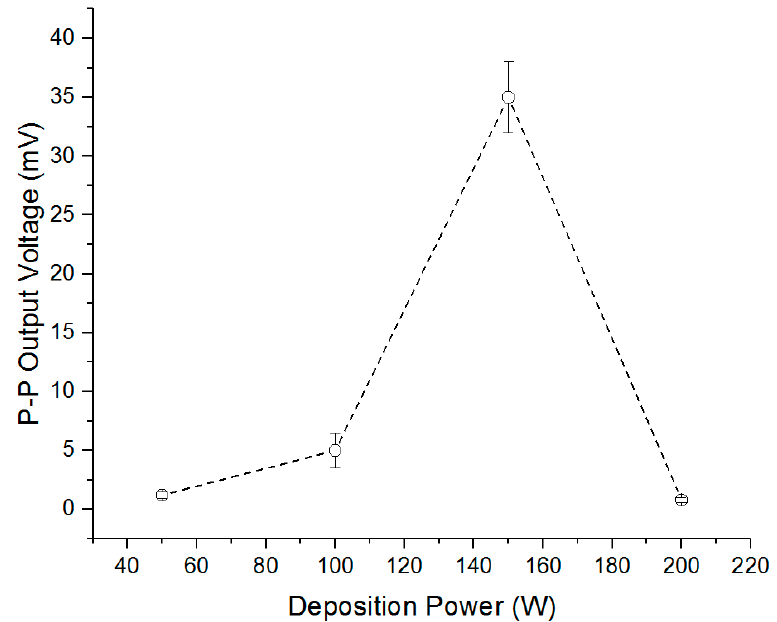
Figure 10 . Peak to peak (P–P) output voltage variations of the ZSZ ‐ MGs with SiO 2 thin films deposited at various radio frequency (RF) powers. Deposition working pressure was fixed at 1.0 × 10 − 2 Torr.